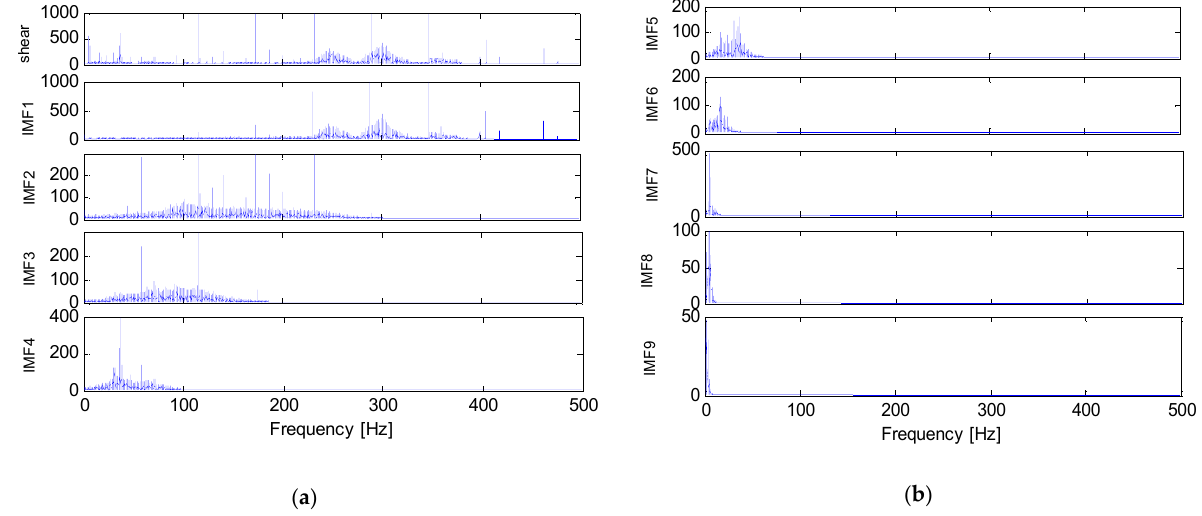
Figure 4. Frequency comparison of the raw velocity shear signals and the IMF modes. ( a ) The frequencies of the raw velocity shear signals and the IMF modes from IMF1 to IMF4; ( b ) The frequencies of IMF modes from IMF5 to IMF9.